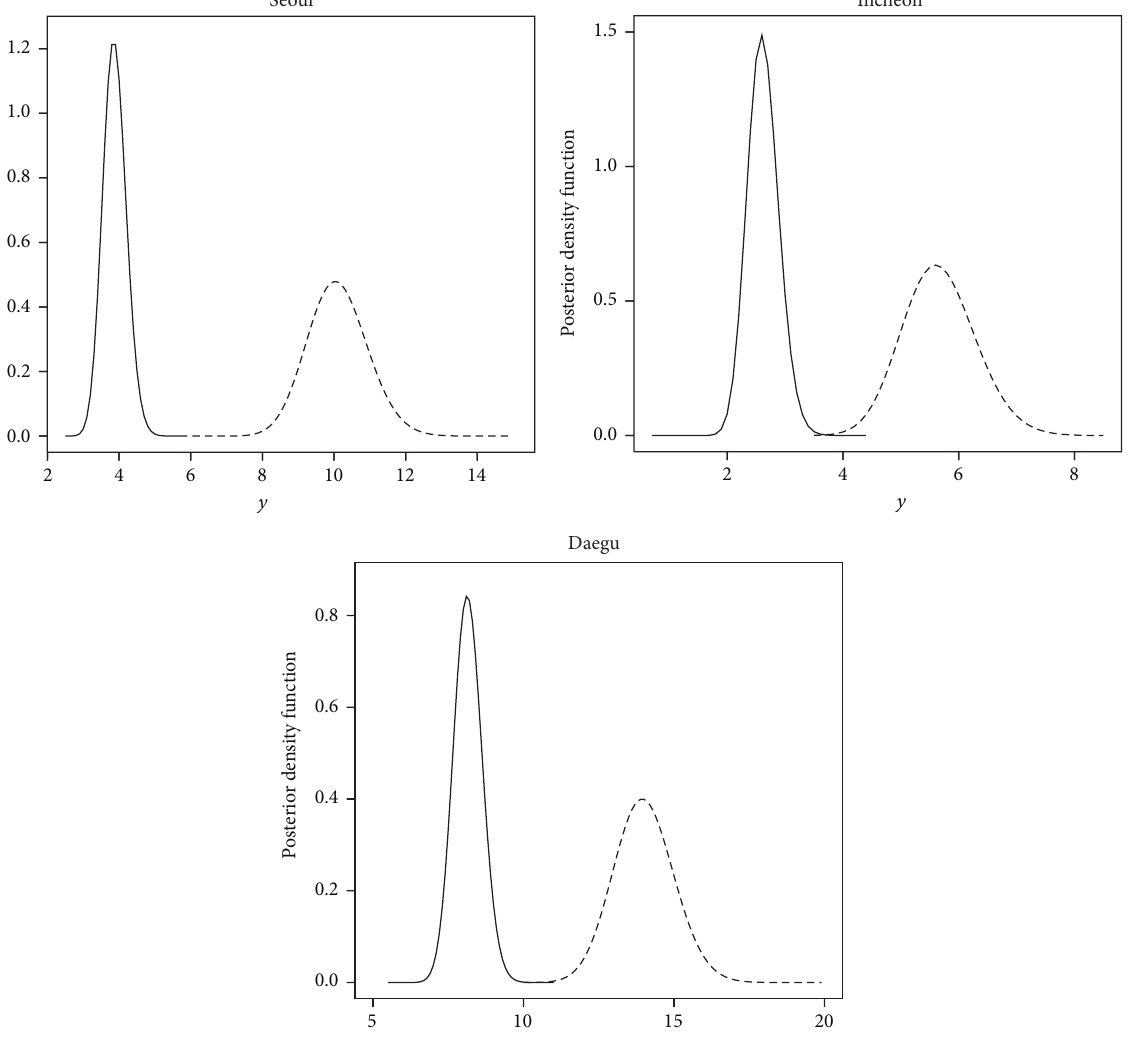
Figure 5: Marginal posterior density functions for parameters 𝜆 and 𝜙 before and after the change-point in 1993.